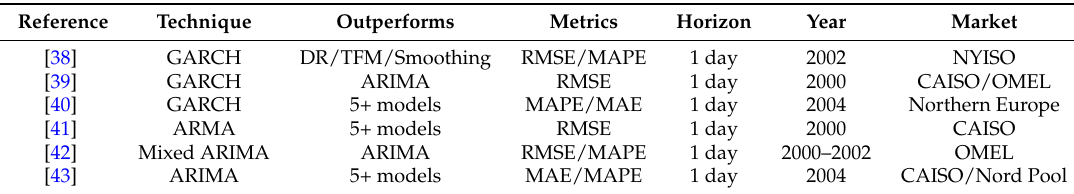
Table 1. Summary on linear